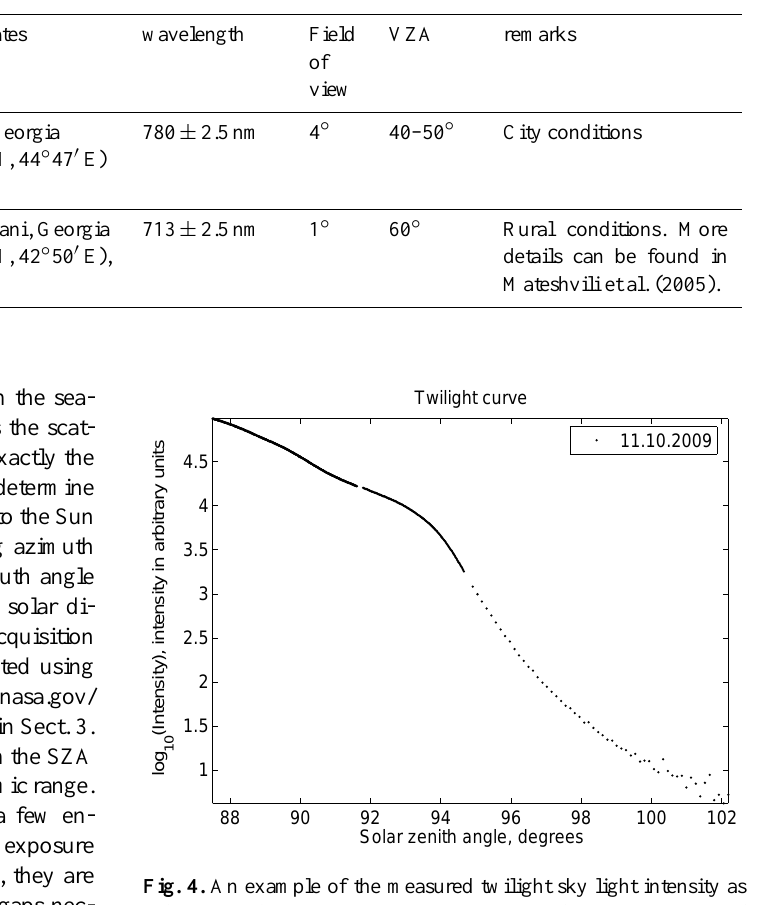
Table 1. Equipment characteristics.